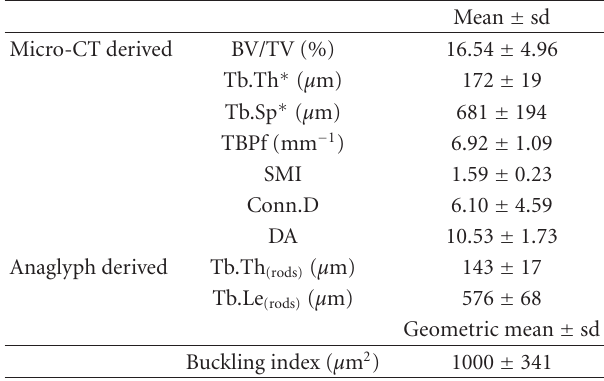
Figure 1: Three-dimensional rendering of voxel-based dataset from a micro-CT scanned sagittal slice of human L1 vertebral body cancellous bone (BV/TV = 9.5%; Tb.Th ∗ = 180 µ m; Tb.Sp ∗ = 1037 µ m; DA = 11.31; TBPf = 6.4mm − 1 ; Conn.D = 1.14mm − 1 , and SMI = 1.58). Scanning resolution = 15.63 µ m/pixel.